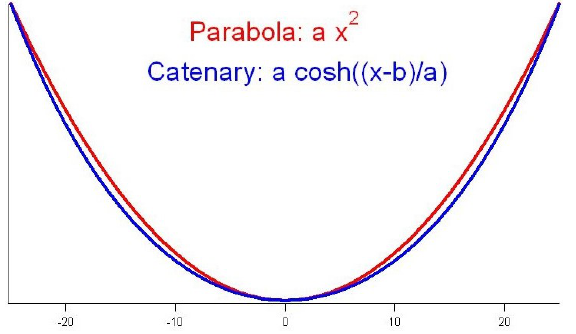
Figure 2. Visual comparison of the catenary and parabola curves with parameter a